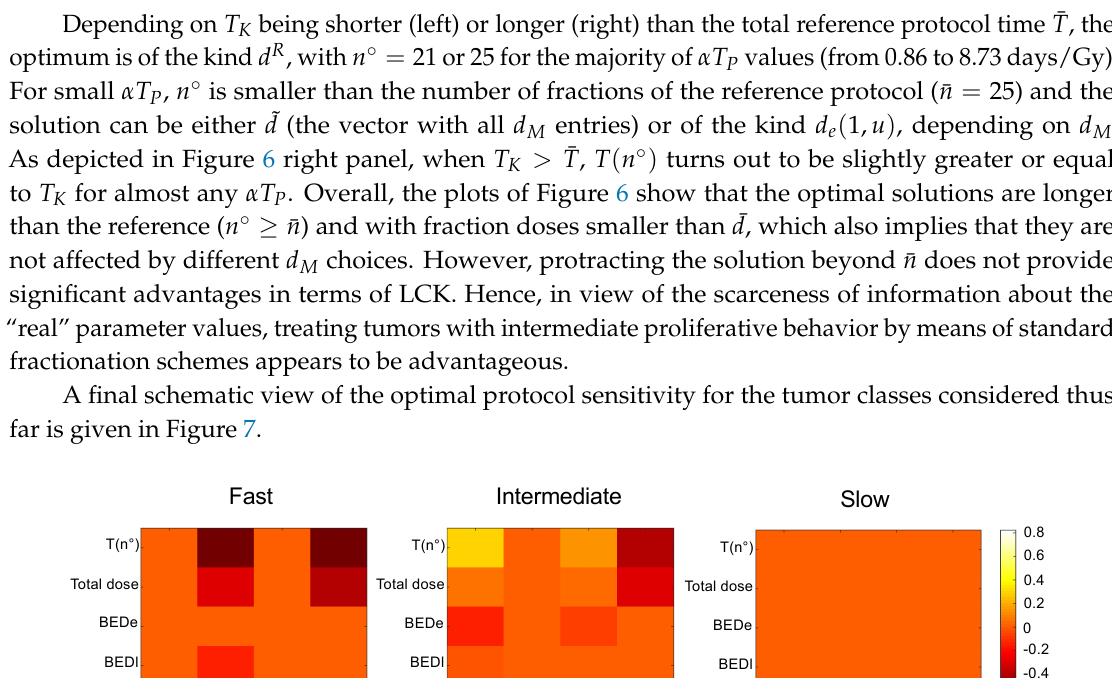
Figure 6. Optimal protocols for tumors with intermediate ρ ( ρ = 4 Gy) as a function of α T P , for different T K . Reference protocol: 25F × 1.8Gy = 45Gy/32 days: ( Left ) T K ≤ ¯ T ; and ( Right ) T K > ¯ T , with ¯ T total reference protocol time. Daily dose upper bound d M = 2.5 Gy.